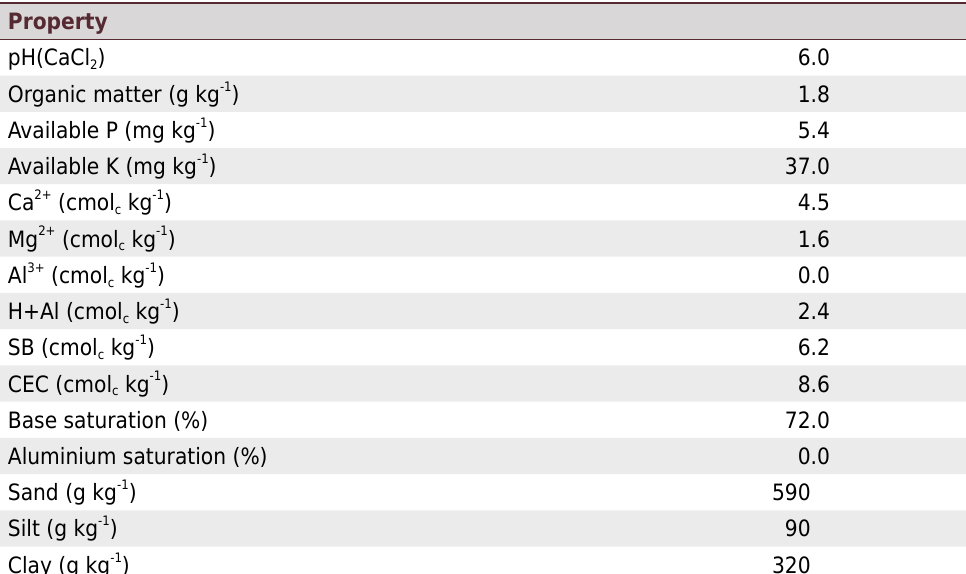
Table 1. Chemical and physical characterization of the soil (layer 0.00-0.20 m) of the experimental area. Araguaína-TO,